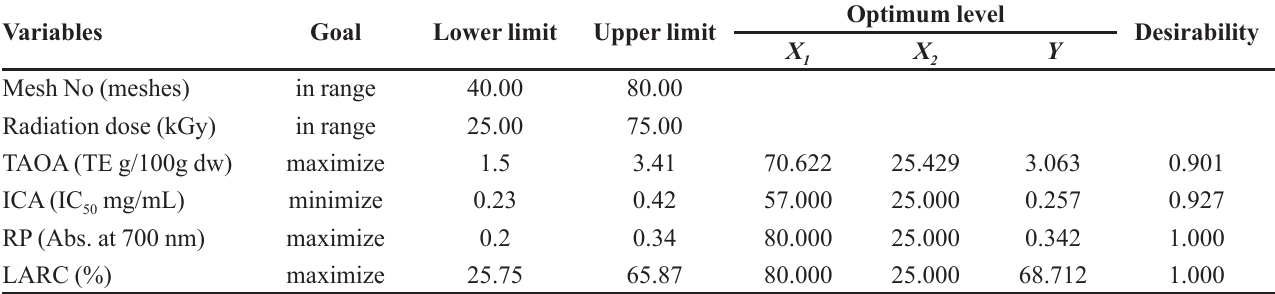
TABLE III - Optimum levels of input variables to achieve the desired goals of response variables with maximum desirability